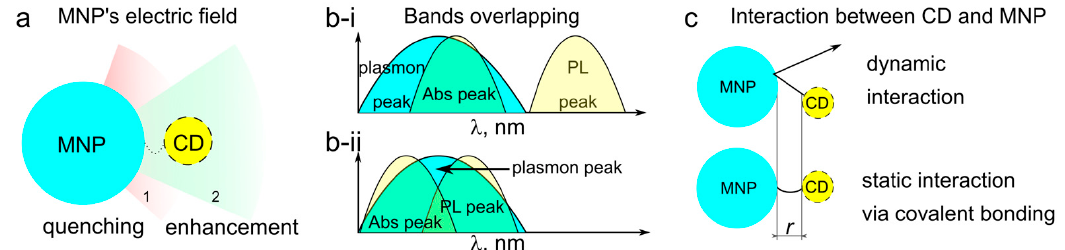
Figure 1. CD and MNP interactions. ( a ) Schematic representation of the influence of the distance between CD and MNP on quenching/enhancement of the CD’s emission. ( b ) Excitation regimes: (i) only the absorption (Abs) band is in resonance with the plasmon peak; (ii) both absorption and PL bands are in resonance with plasmon peak of MNP. ( c ) Interactions of CD and MNP: dynamic by attractive and repulsive forces in colloidal solution; static via covalent bonding of CD to the surface of the MNP.